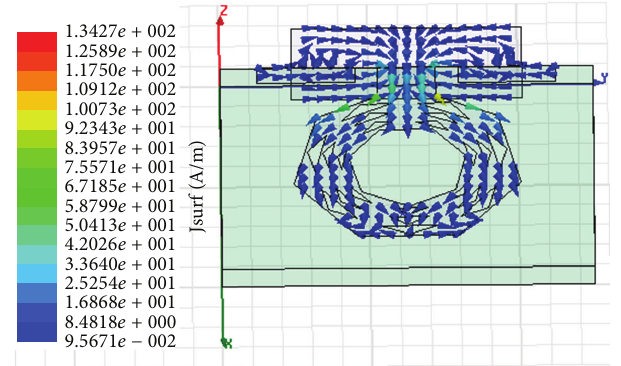
Figure 9: Simulated 3D radiation pattern plot for 10GHz.